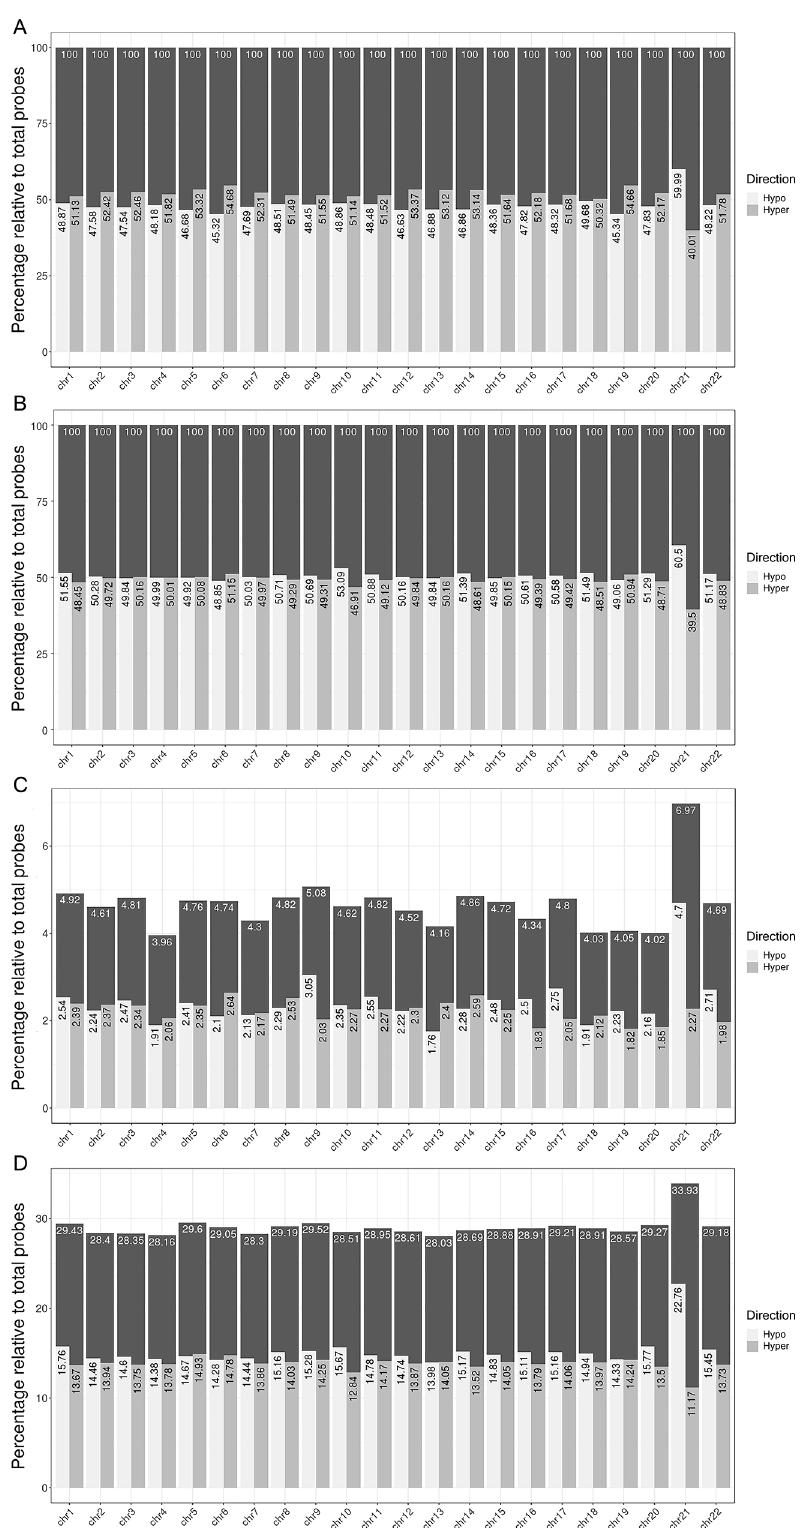
Fig 4. Distribution of hypo -and hypermethylation over the autosomes in DS vs. controls. (A) Relative to the total number of probes, percentages of hypo- and hypermethylated probes. Hypomethylated δ < 0, hypermethylated δ > 0.